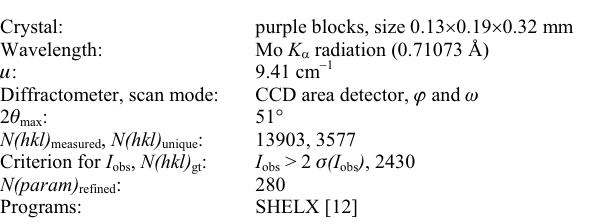
Table 1. Data collection and handling.